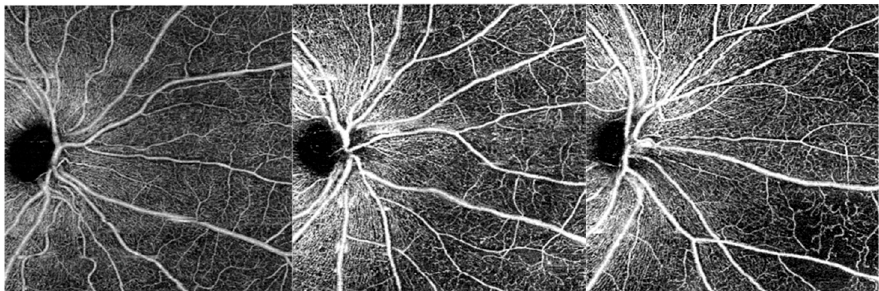
Figure 7. OCT-A C-scans of the superficial capillary plexus (SCP). From left to right: examples of a patient without DR, a patient with mild NPDR and a patient with severe NPDR. The vessel density in the SCP progressively decreases with DR severity, especially in the most peripheral area. DR, diabetic retinopathy; NPDR, non-proliferative diabetic retinopathy.